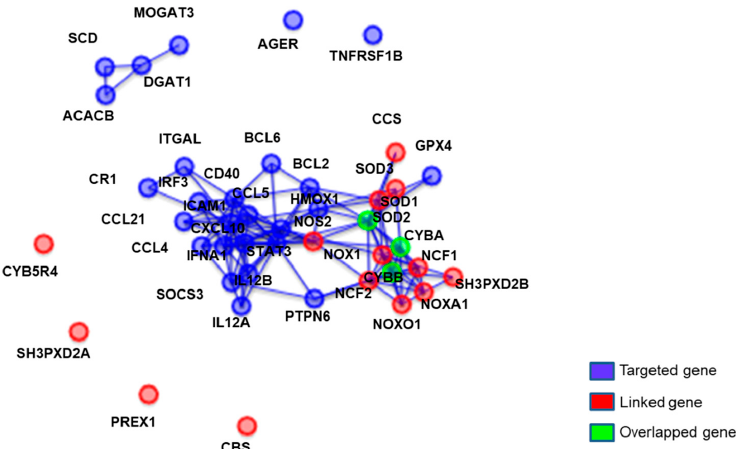
Figure 4. Network of up-regulated genes changed by eight-week PMP supplementation. Genes were selected based on differential expression pattern compared to placebo. Each node represents a physical entity. Each edge represents a gene regulatory interaction. Blue circles are genes that are targeted and analyzed by PCR analysis. Red circles are genes related process given by EnrichNet database (http://enrichnet.org), but not analyzed. Green circles denote overlapped gene between blue and red genes.